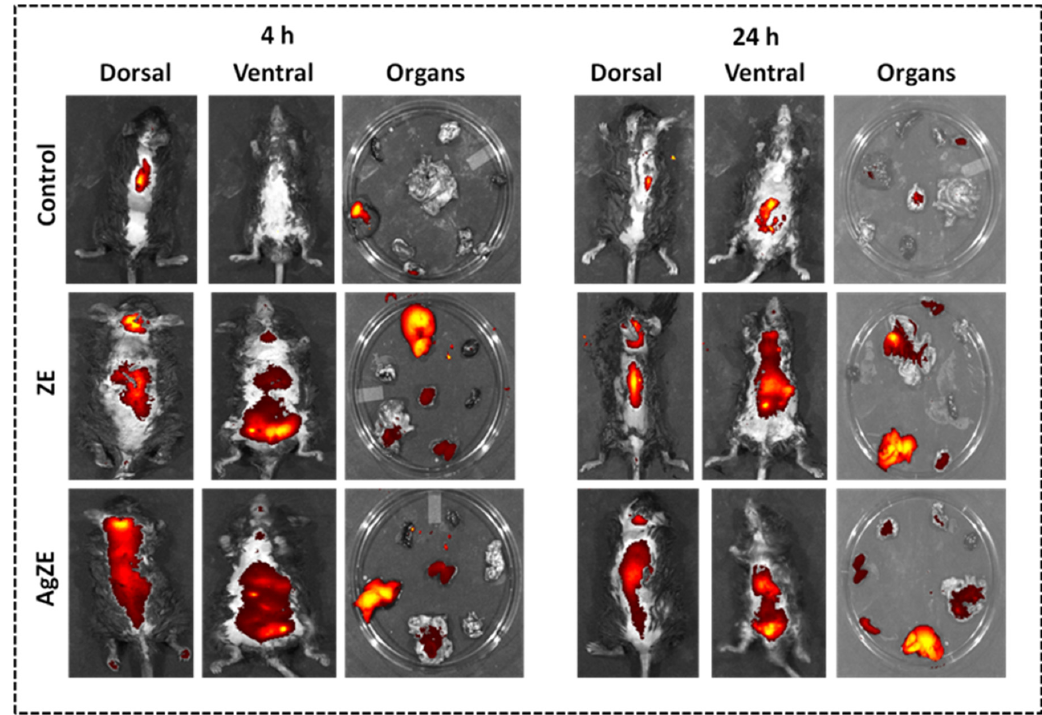
Figure 10. Representative images of in vivo and ex vivo biodistribution of ZE and AgZE in C57BL6/J female mice using a non-invasive in vivo imager at 4 to 24 h time points. Panel I: 4 h, Panel II: 24 h; Column I: dorsal side, Column II: ventral side, and Column III: organs of the C57BL6/J mice. Row I: Control mice; Row II: i.p. injected ZE mice; and Row III: i.p. injected AgZE mice. The images of the mice are taken at 710 nm excitation and 820 nm emission. The brain, heart, lung, liver, colon, kidney, and spleen show fluorescence upon intraperitoneal injection with ZE and AgZE, indicating their maximum distribution into those respective sites. These experiments are performed thrice.